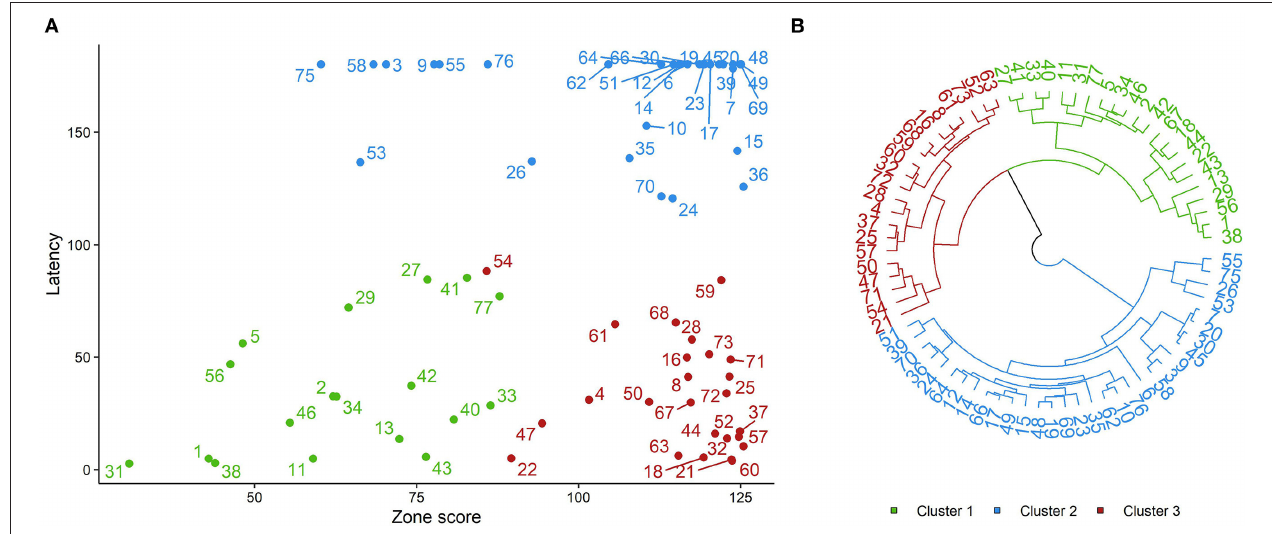
FIGURE 2 | Results of sheep classification using K-means (A) and Hierarchical clustering (B) based of selected variables from four behavioral tests. Individuals with the same color belong to the same cluster. Latency was defined as time (secs) to make first contact with the novel object. Zone score quantified the total time spent near the human and other sheep versus other zones (for a full description of the zone score calculation see Arena Test). the paddock. The second habituation day involved attaching a dog harness to each sheep (Comfy Harness, size 8, 84–120 cm, Company of Animals, Surrey, UK). For ease of checking and identification, each sheep was also numbered with colored wool marker (Heiniger Shearing Supplies, Bibra Lake, WA, Australia) that matched different colored antennas on the RTK rovers. The 3 test days then commenced by fitting an RTK rover to the dog harness and securing it onto the back of the sheep using cable ties ( Figure 3 ). Three days were selected to align with the battery capacity of the devices.